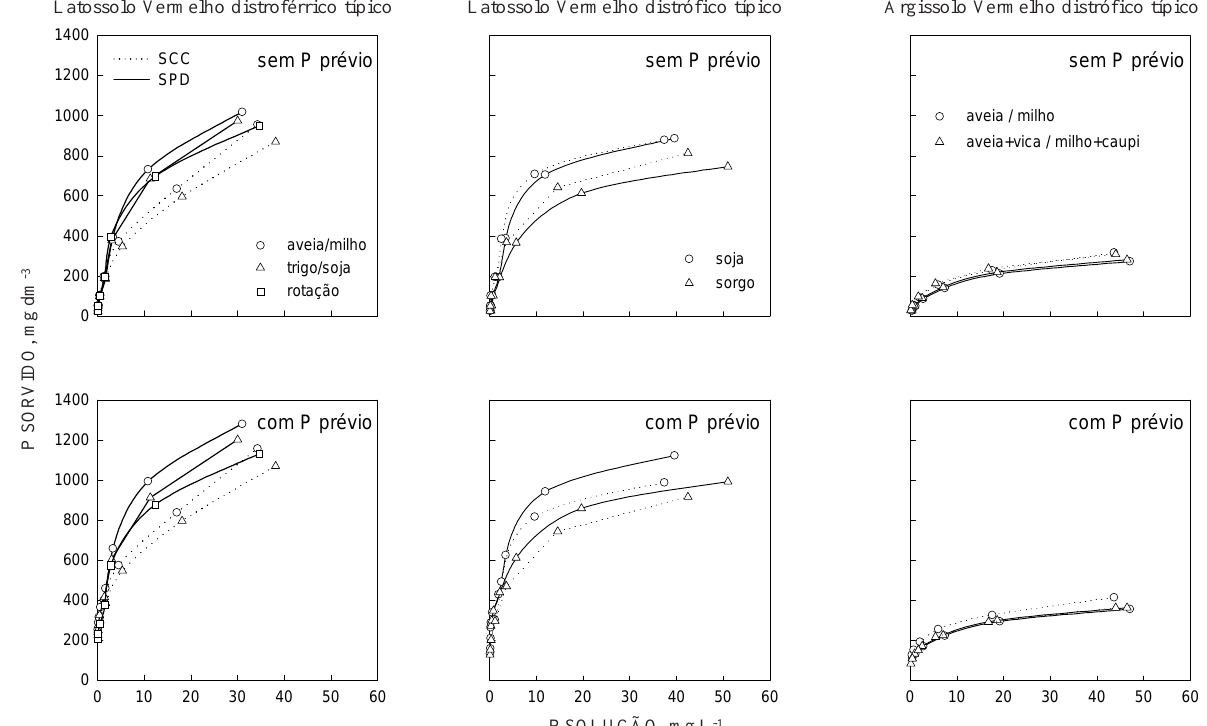
Figura 2. Relação entre o fósforo sorvido e o fósforo da solução da camada de 2,5-7,5 cm, sem e com a inclusão do fósforo previamente sorvido em diferentes solos, métodos de preparo e sucessões de